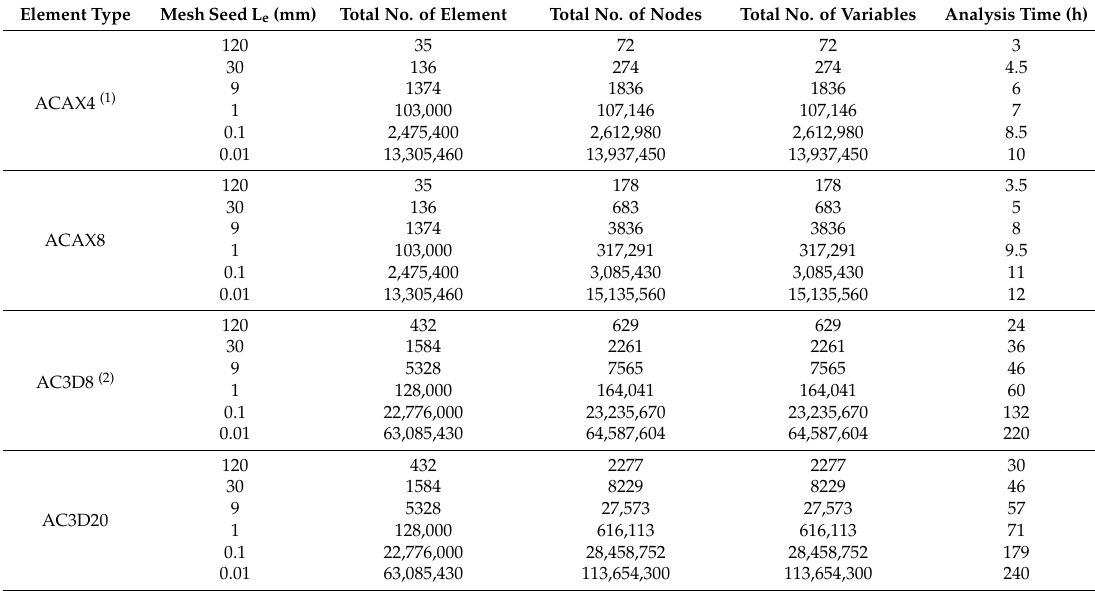
Table 3. Basic acoustic mesh sensitivity study.